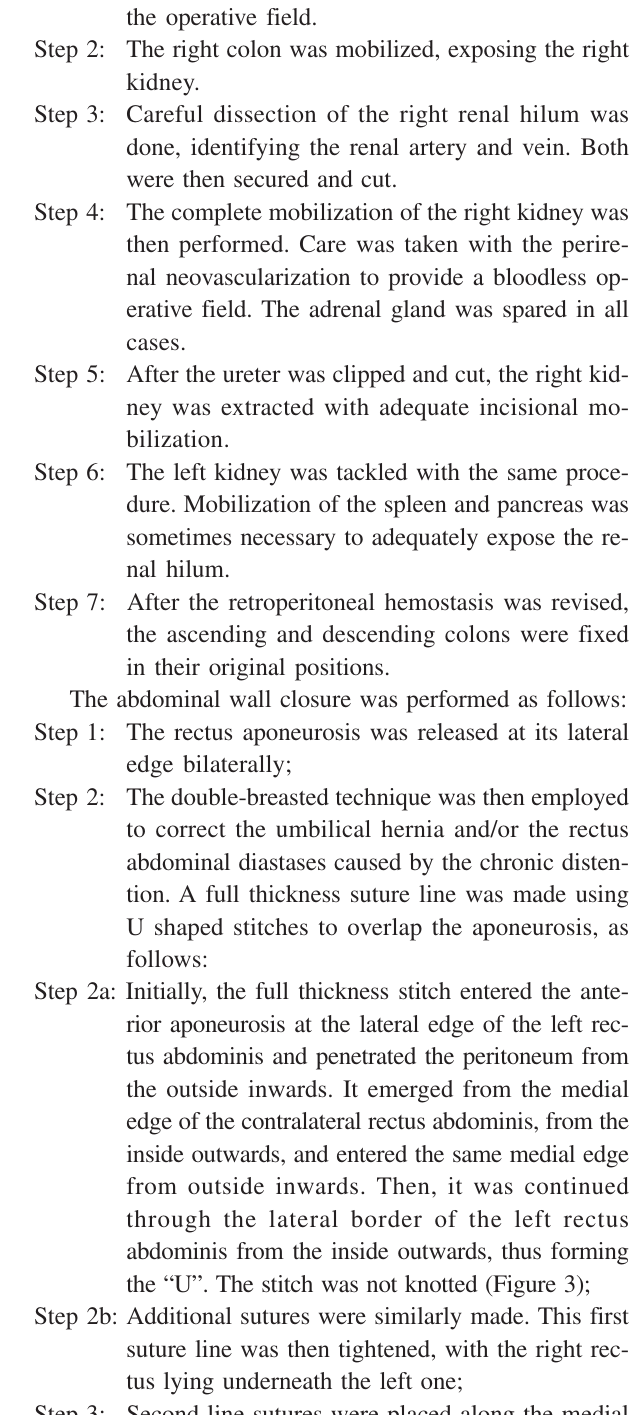
Figure 2 - Rectus abdominis diastasis and umbilical hernia in a ADPKD